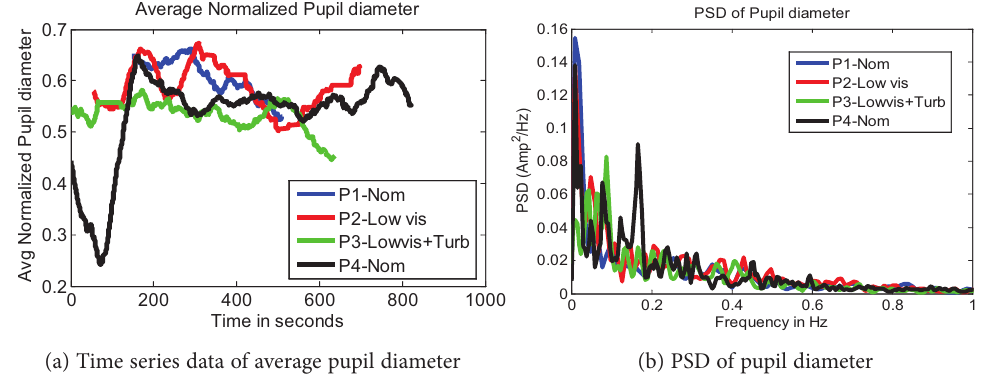
(a) Time series data of average pupil diameter (b) PSD of pupil diameter Figure 11. Pupil diameter plots